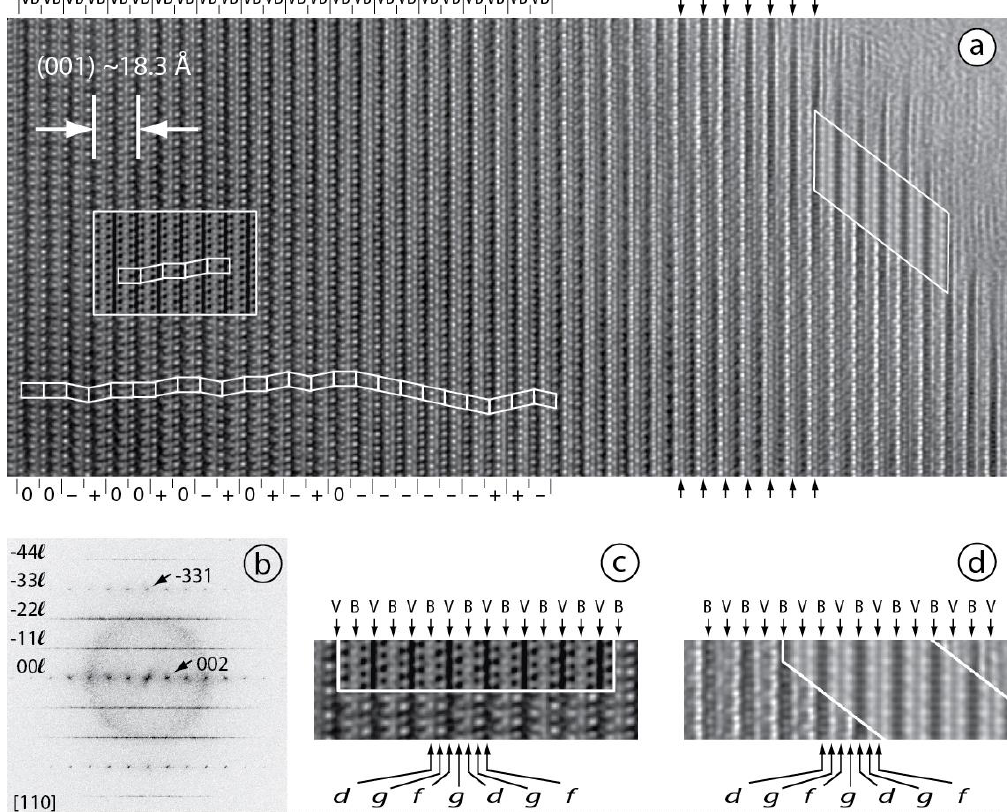
Figure 11. ( a ) Filtered [110] HRTEM image of synchysite-(Ce) from Cinquevalli. ( b ) Related FFT pattern. The latter shows distinct reflections along hhl rows with h = 3 n , and severely streaked hhl rows with h (cid:44) 3 n , indicating absence of polysomatic disorder and extensive polytypic disorder. Consistently, the HR image shows (002) half-cells with varying slants, but constant interplanar distance (lower left). Therefore, the VBVB sequence is maintained throughout the crystal, as well as the composition, but the relative orientation of the VB -layers within the sequence may be di ff erent from cell to cell. The white boxes in ( a ) include simulations for two di ff erent thickness and defocus conditions, which are in part reproduced and magnified in ( c ) (thickness = 15 nm, defocus = 43 nm, atomic vibrations = 0.05 nm) and ( d ) (thickness = 3.5 nm, defocus = 45 nm, atomic vibrations = 0.09 nm), respectively. Although disordered and a ff ected by beam damage, the HR images allow recognition of vaterite ( V ) and bastnäsite ( B ) layers as alternating bright and dark fringes. Note, however, as dark and bright fringes invert contrast with increasing thickness of the thin foil (top and bottom arrows in ( a ) are aligned vertically).